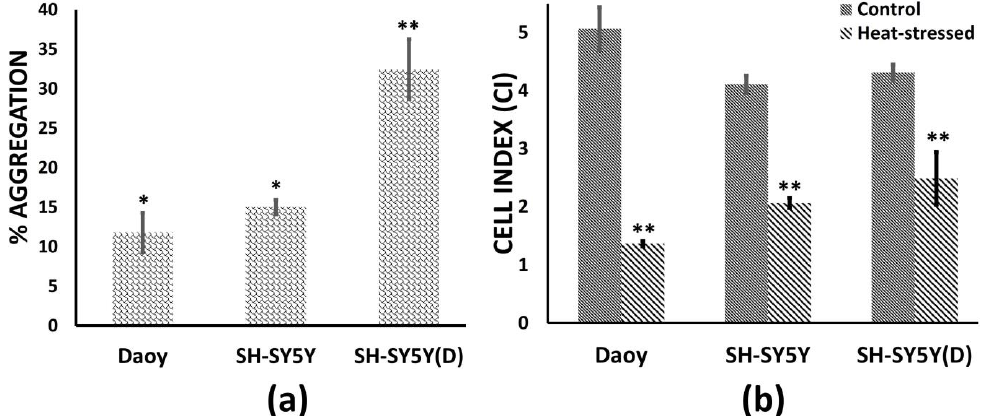
Figure 1. Protein aggregation and cell proliferation in heat stress models (ET: 44 °C, ED: 2 h) of medulloblastoma [Daoy], neuroblastoma [SH-SY5Y], and differentiated SH-SY5Y [SH-SY5Y(D)]. ( a ) Protein aggregation is measured immediately after heat stress, that is, recovery time 0 h. The per- centage change in aggregation of heat-stressed cells in comparison to the proteome of control cells (37 °C) corresponds to the percentage change in measured fluorescence. ( b ) The cell index (CI) val- ues depicted here are 24 h after heat stress and show a measurable reduction in the three cell types. Statistically significant stress is measured both in protein aggregation and cell proliferation (* p < 0.05 ** p < 0.01).